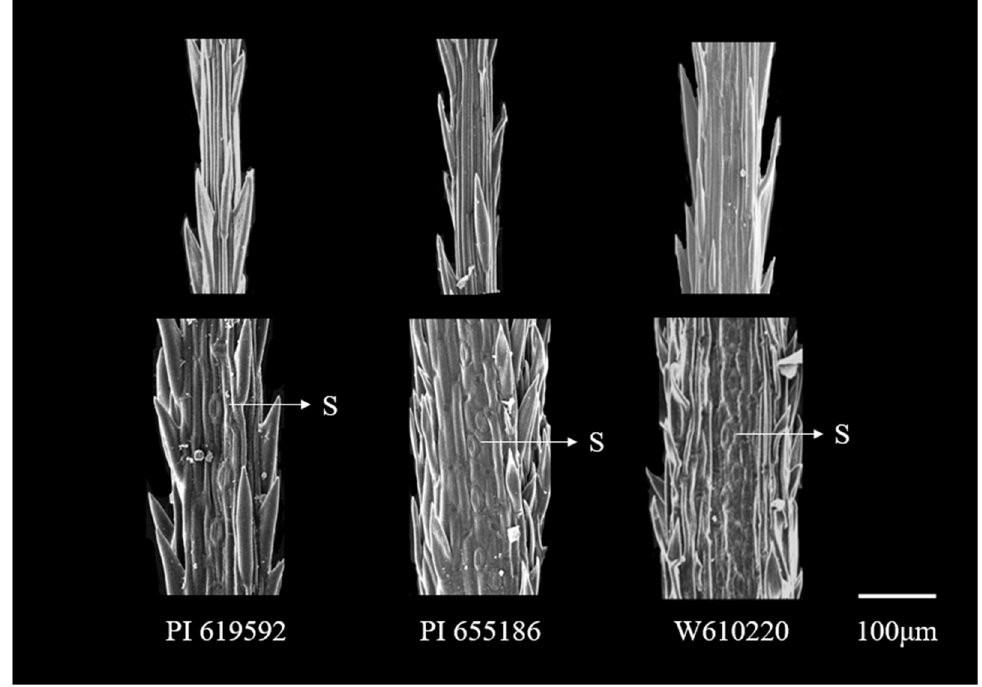
Figure 3. The upper and lower images of the awns of three accessions at heading stage. W610220, long awn, PI 655186, medium awn, PI 619592, short awn. S: Stomas.